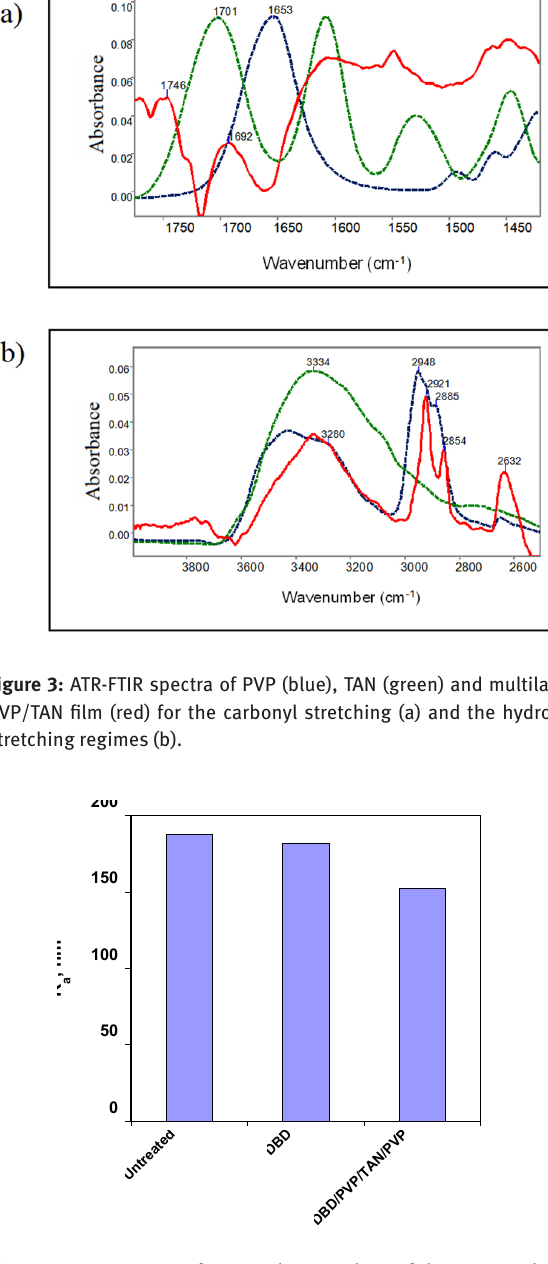
surface roughness values of the untreated and Figure 4 : Average R a treated surfaces.